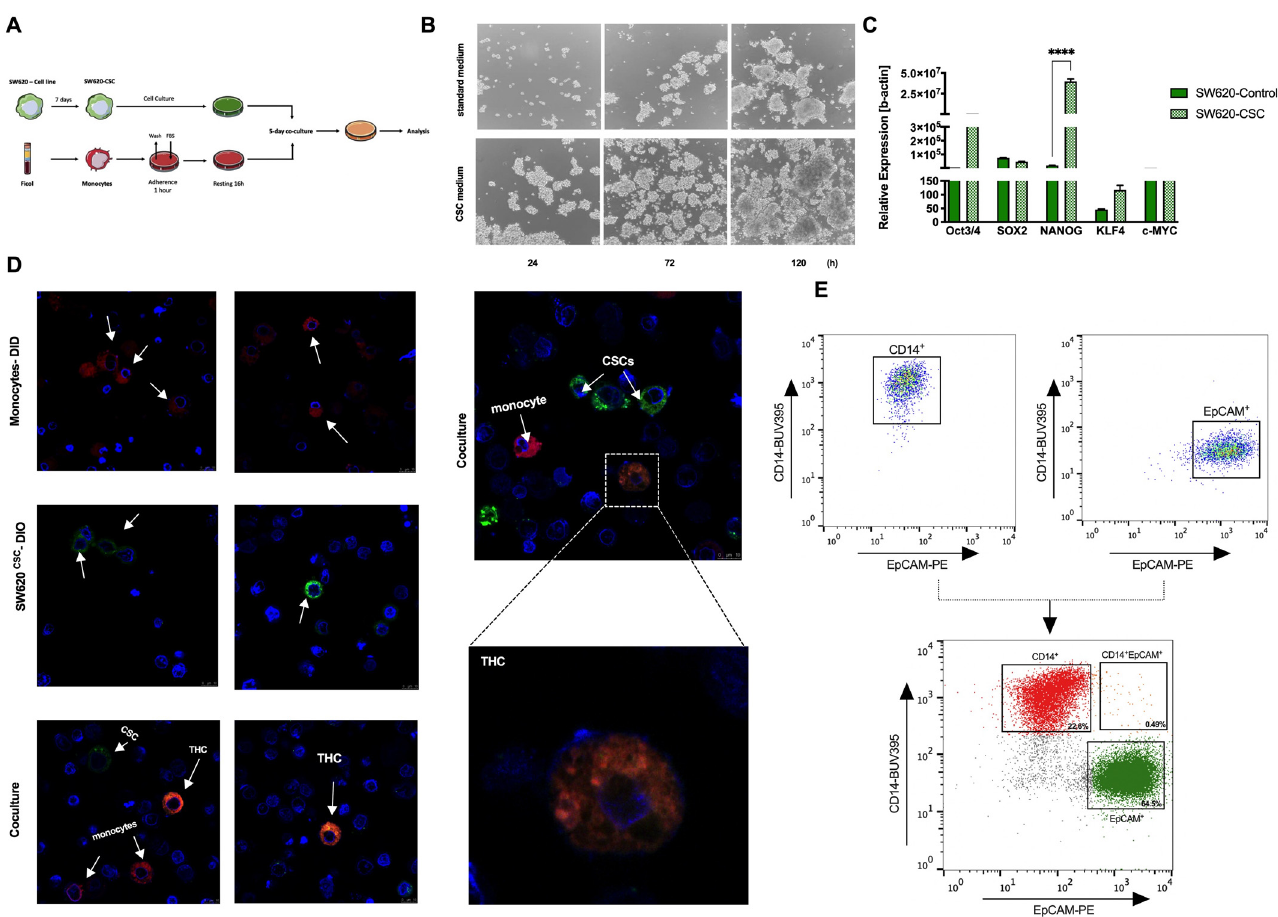
Figure 1. CRC stem cells fuse with human monocytes in vitro. ( A ) Schematic representation of experimental co-culture conditions. ( B ) Brightfield microscopy images at 24, 72 and 120 h showing morphological differences between standard (upper panel) and CSC (lower panel) medium. ( C ) Relative expression of OCT3/4, SOX2, NANOG, KLF4 and cMYC pluripotency genes in SW620-control (filled green) and SW620-CSC (dotted green) cells (n = 3). ( D ) Representative confocal images of co-cultured DIO stained SW620CSC (green) with DID stained monocytes (red) and DAPI for nuclei (blue) is shown (n = 3). Zoomed image of THC (tangerine) can be observed (63× magnification). ( E ) Representative FACS analysis gating strategy illustrating EpCAM+ and CD14+ single stainings and after 5 days of co-culture illustrating EpCAM + SW620CSC (green), CD14 + human monocytes (red) and CD14 + EpCAM + (THCs, tangerine); ****, p < 0.0001; see details in Supplementary Figure